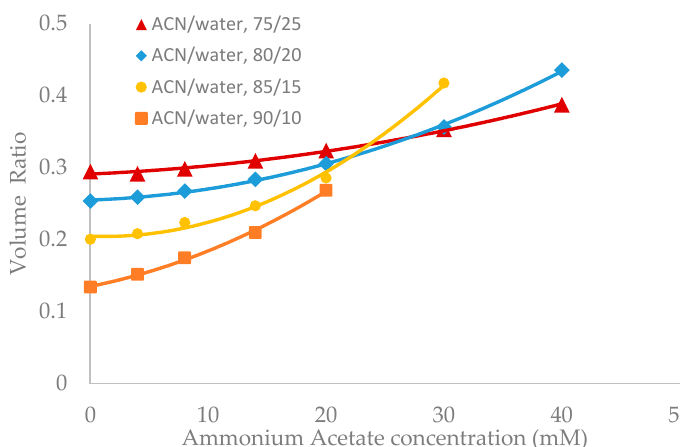
Figure 3. The effect of ammonium acetate concentration on the volume ratio values ( β ) for ZIC-HILIC (3.5 µm, 100 Å, 4.6 × 150 mm). Column temperature is 25 °C.